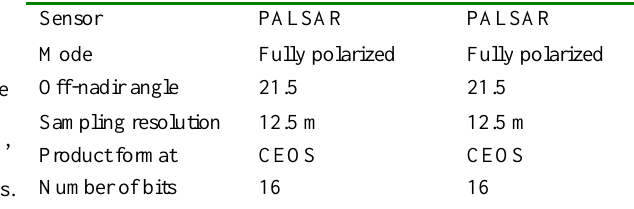
Table 1. Image acquisition